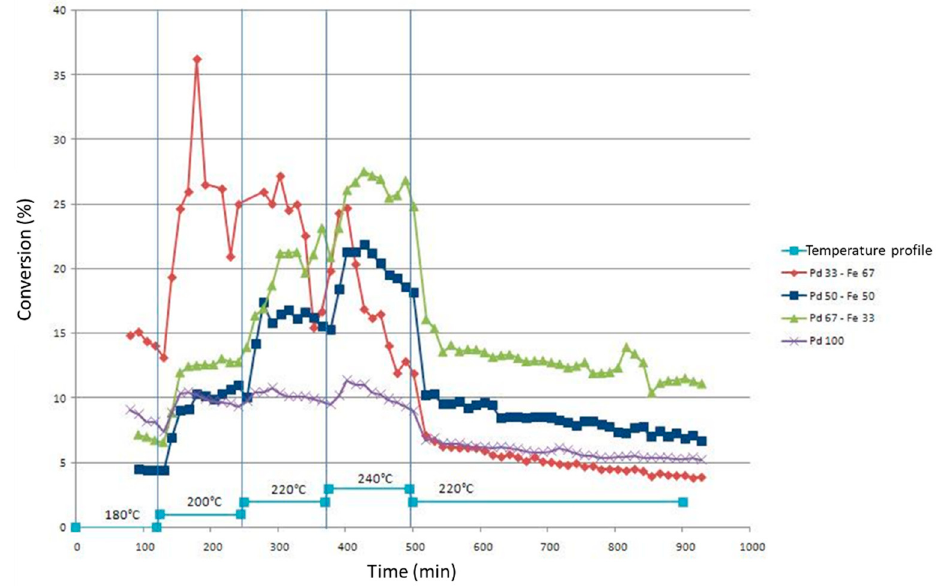
Figure 7. Comparison of the conversions of chlorobenzene to benzene as a function of time for the Pd-Fe/SiO 2 series.